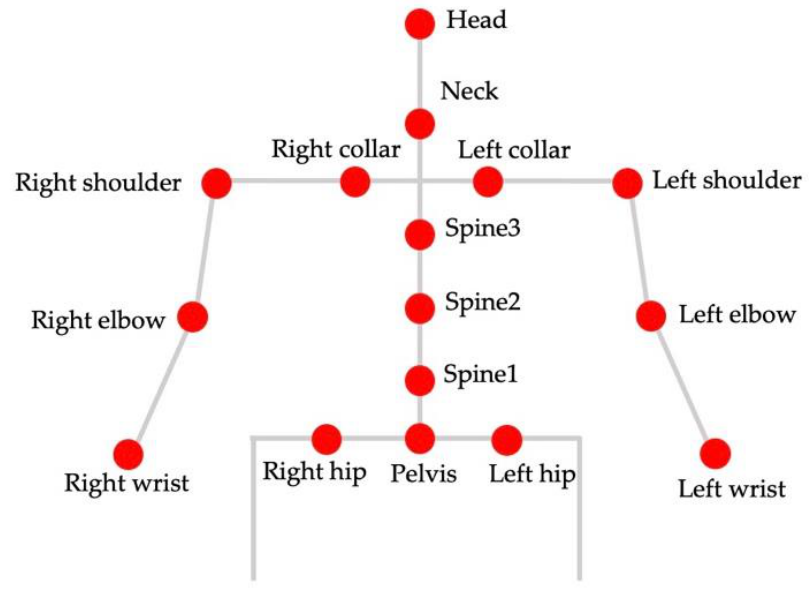
Figure 8. Body joints calculated from the camera